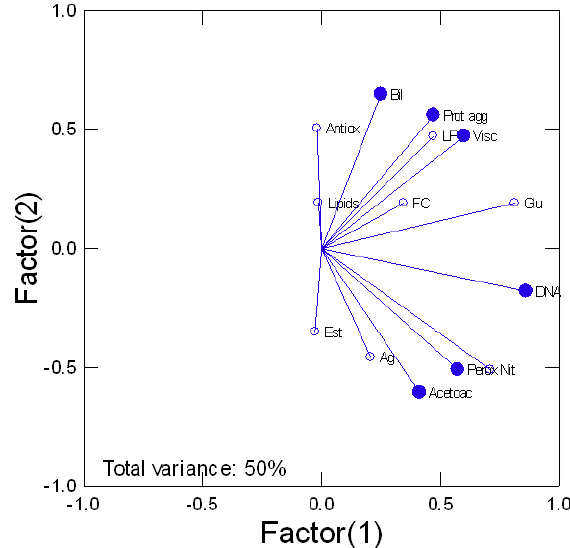
Figure 6. Principal component analysis of biomarker data. The principal component analysis of bi- omarker data is shown. The total variance explained was at 50% and the most important biomarkers (weight > 0.7) are highlighted with the fi lled circles. The relative level of Ag is shown as the fi lled square. the filled